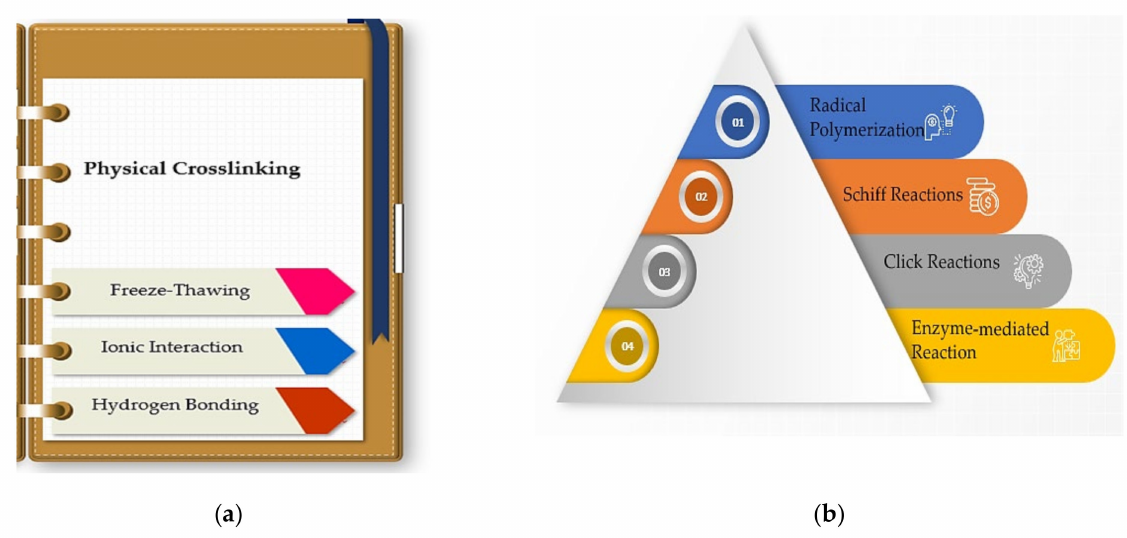
Figure 3. The main methods of ( a ) physical and ( b ) chemical crosslinking of hydrogels. Physical crosslinking represents one of the most used crosslinking methods for de- veloping polymeric scaffolds. The resulting materials obtained from physical crosslinking are physical or reversible hydrogels. They can also be dissolved in the selected environ- ment; the degree of dissolution can be changed by varying the pH or temperature